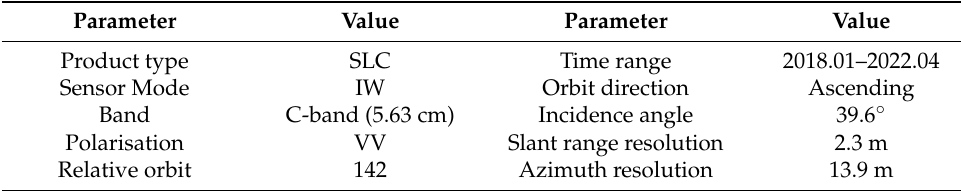
Table 1. Specific parameters of Sentinel-1A data.